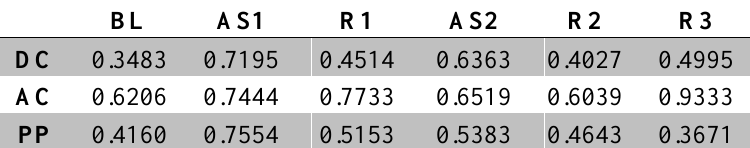
Table 2. The p-value of inter-group